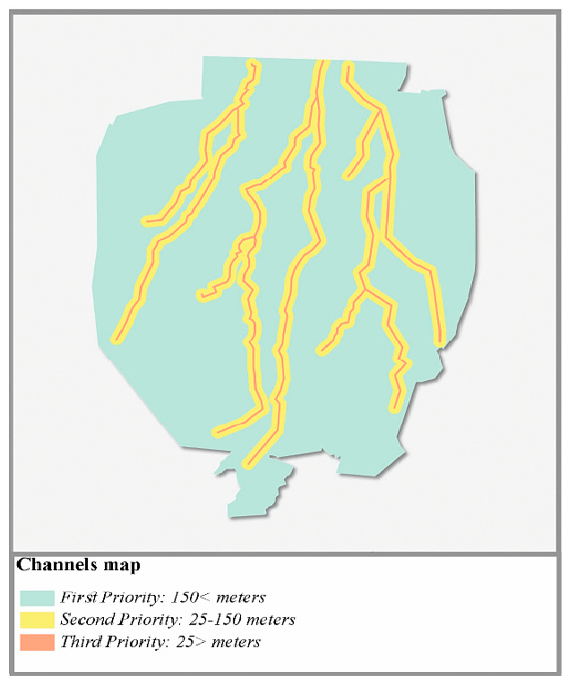
Figure 6. The channels map of Hamedan based on the sub-criteria measures in Table 1.